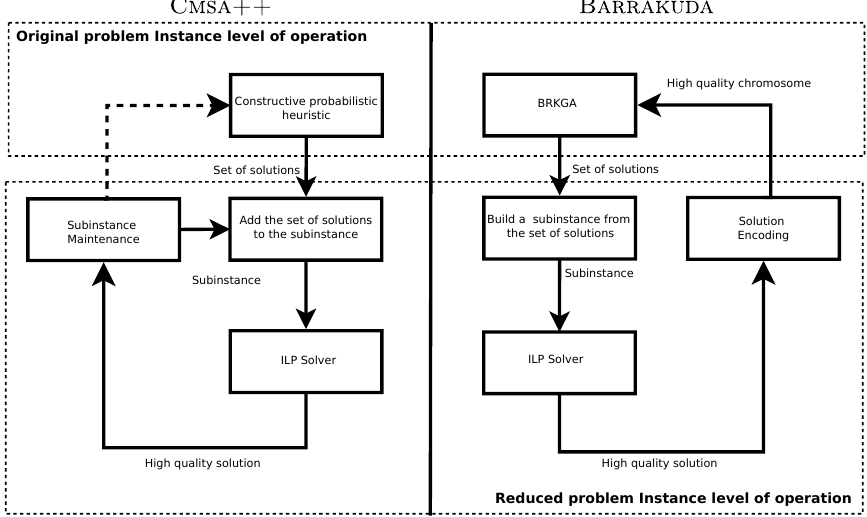
Figure 2. High-level overview of the two proposed hybrid